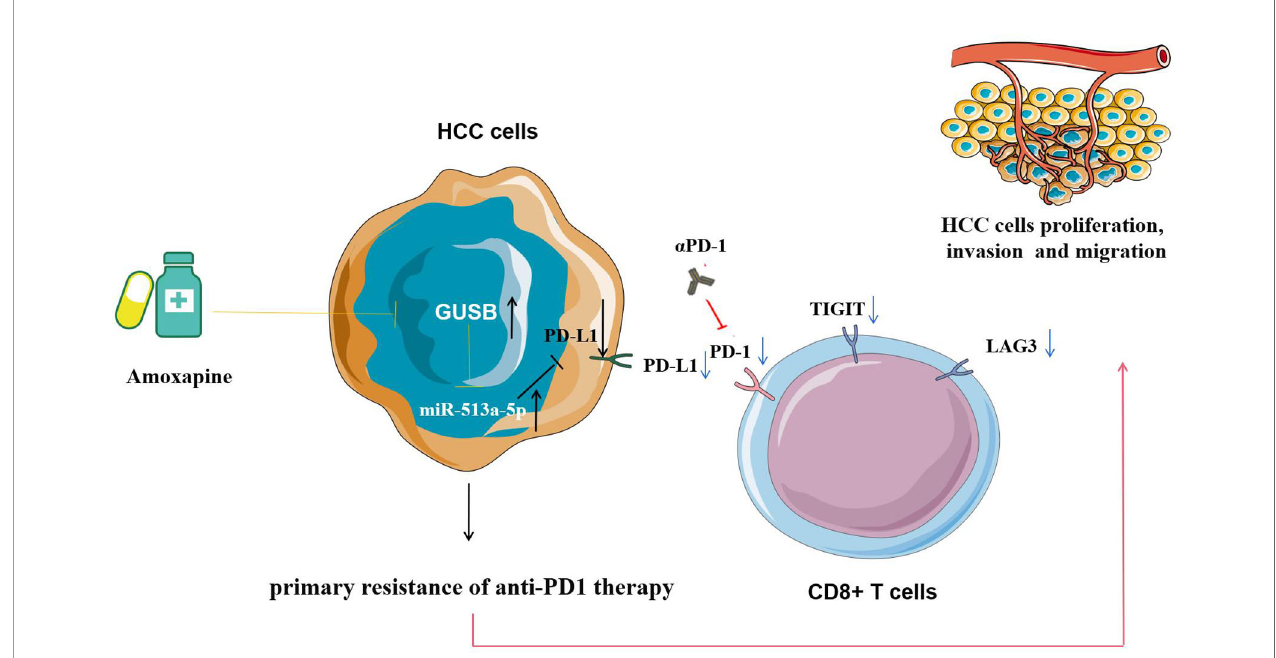
FIGURE 9 | Pattern diagram showing that increased GUSB inhibits the expression of PD-L1 by promoting miR-513a-5p expression, leading to primary resistance to anti-PD1 therapy in HCC, and the use of amoxapine enhances the sensitivity of anti-PD1 therapy by inhibiting GUSB in